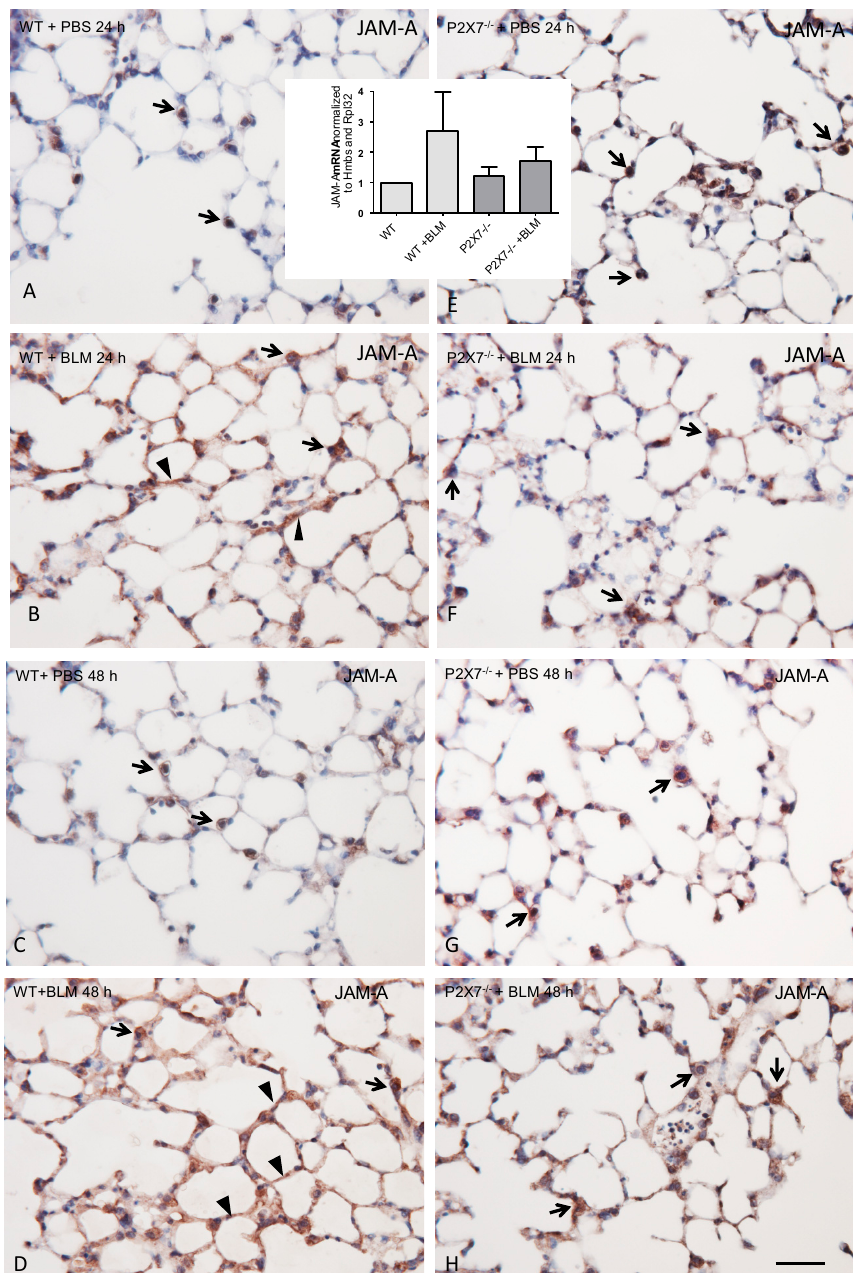
Figure 2. Paraffin sections from embedded PCLS after 300 mU/mL BLM exposure for 24 h ( A , B , E , F ) and 48 h ( C , D , G , H ). Immunoperoxidase demonstration of JAM-A in WT ( A – D ) and P2X7 − / − ( E – H ) mice. Note the preferable immunostaining of AECII in untreated WT (arrows in A , C ), a weak increase in P2X7 − / − mice ( E , G ), and the strongest immunostaining of the AECs in the BLM-treated WT mice ( B , D ). Arrowheads depict the alveolar lining of JAM-A immunoreactivity. Bar = 100 µm. Inset over ( A ) and ( E ): Analysis of mRNA content in paraffin sections of PCLS from WT and P2X7 − / − mice after 24 h. mRNA content of JAM-A was analyzed by quantitative real time RT-PCR using Hmbs and Rpl32 as housekeeping genes. Charts are represented as mean ± SEM (WT normalized to 1; n = 3; p -value 0.4550).